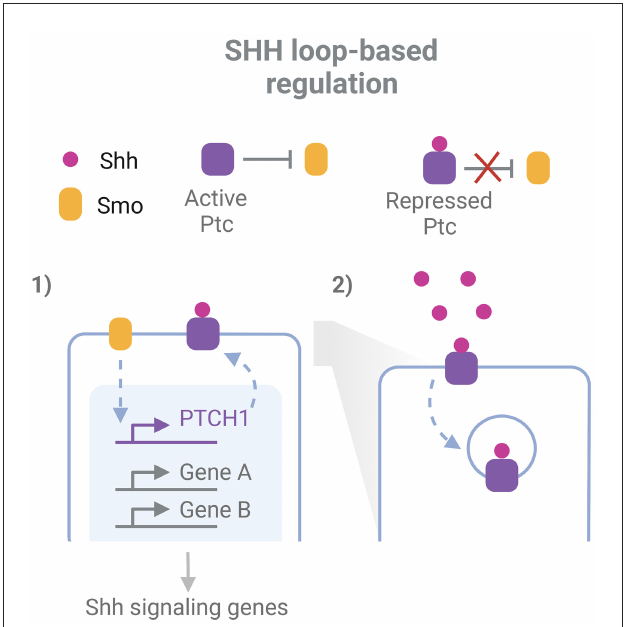
FIGURE1 Example of network-level robustness for the action of a morphogen in neurodevelopment. Two feed-back loops participate in the robustness mechanism for the cellular responde to Shh in the neural tube: 1. Smo indirectly induces transcription of the PTCH1 gene. This gene codes for the protein Ptc, which represses Smo activity and is inhibited by Shh binding; 2. After Shh binding, Ptc mediates its endocytosis and degradation. Inspired in Sagner and Briscoe (2017) and Ferent et al. (2019). Created with BioRender.com.